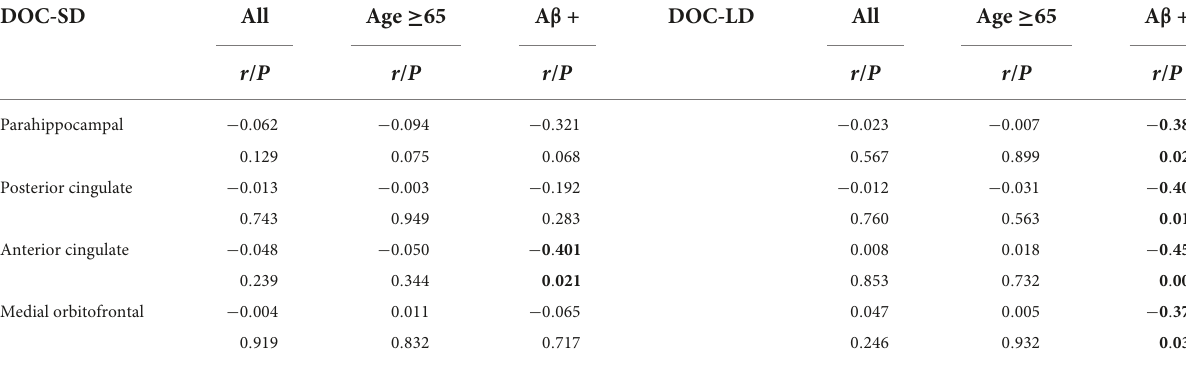
TABLE 5 Partial correlation between metamemory scores and cortical